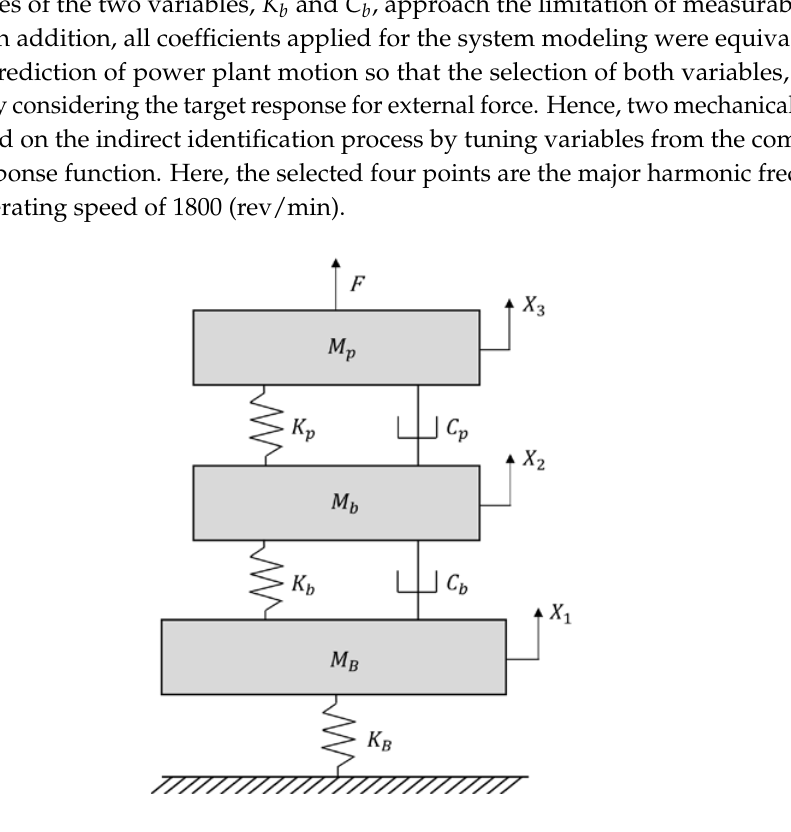
Figure 3. Equivalent system model of electric power plant supported by current mount module. Table 2. Mechanical properties for main harmonic spectrum. Table 2. Mechanical properties for main harmonic